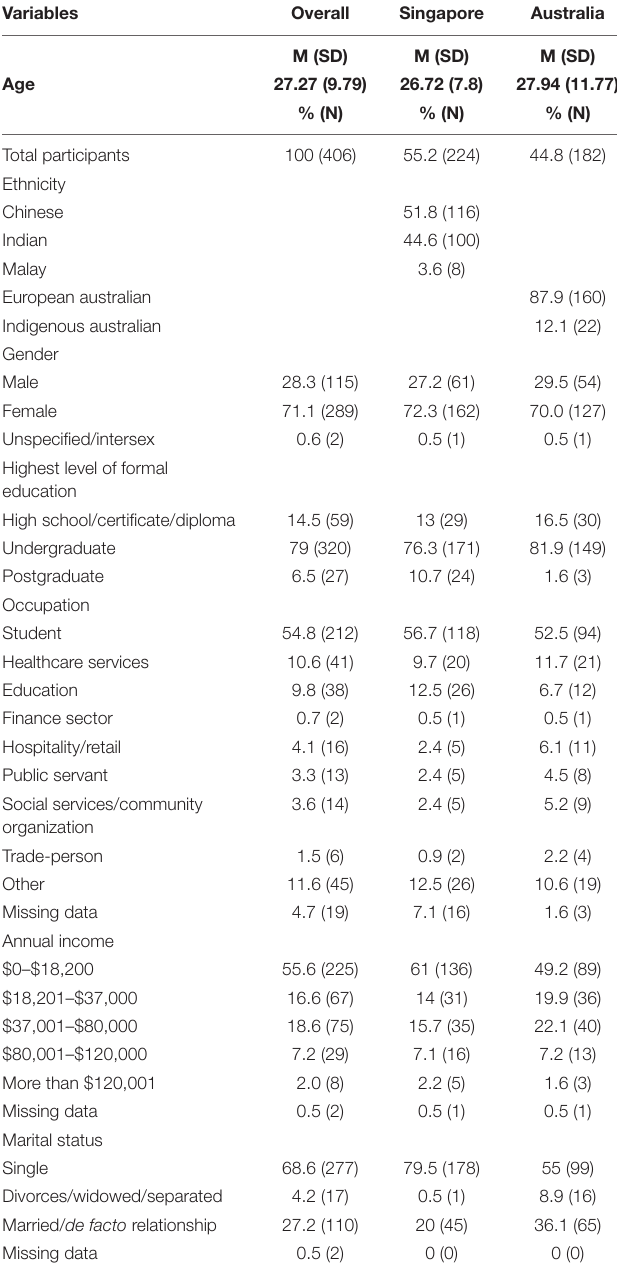
TABLE 1 | Demographic characteristics of the